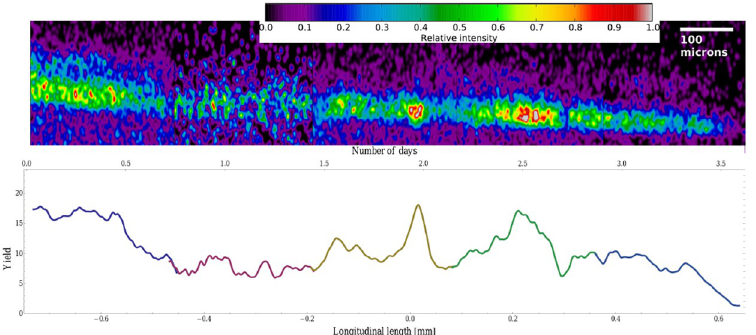
Fig 6. Top : The distribution of the cocaine signal along the user’s hair sample. Bottom : Laterally integrated cocaine intensity along the hair sample. Different colours represent different peaks or regions of interest in the spectrum. As explained in the text, the time scale was approximated with the average hair-growth rate of 0.4 mm/day.